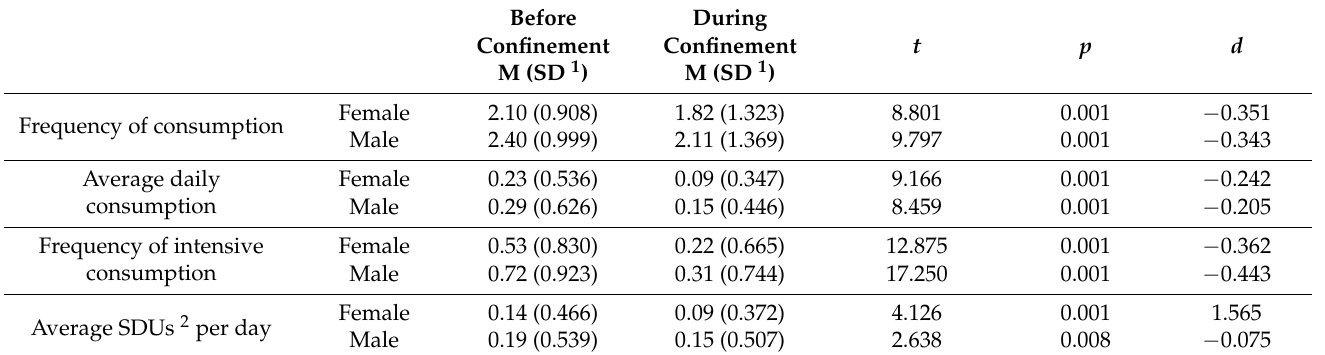
Table 2. Alcohol consumption patterns before and during confinement as a function of gender.